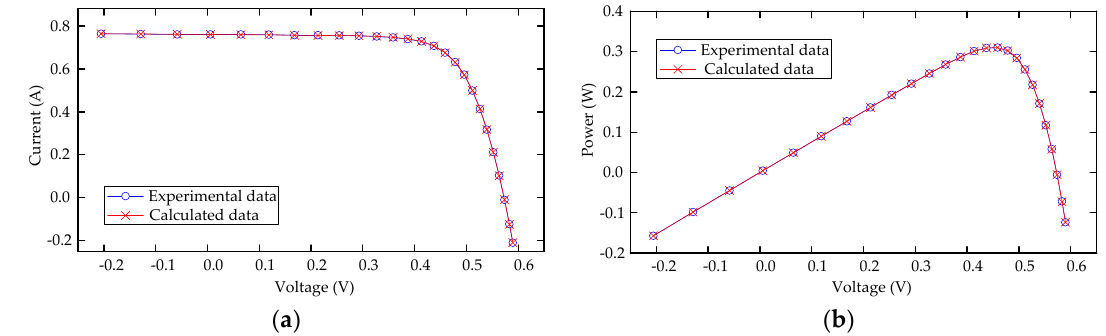
Figure 5. Comparisons between the experimental data and calculated data obtained by the proposed ImCSA for the SDM of RTC France silicon solar cell: ( a ) I-V characteristics; ( b ) P-V characteristics.